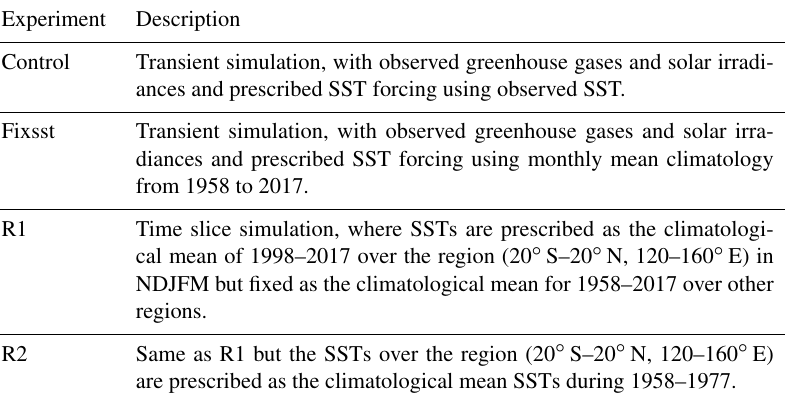
Figure 2. Trends of vertical velocity and horizontal winds at 150, 500, and 700hPa in NDJFM (November–March), as derived from JRA55, ERA5, and MERRA-2 data. The trends of horizontal winds (arrows; 10 − 1 ms − 1 a − 1 ) and vertical velocity (shading; 10 − 4 ms − 1 a − 1 ) at (a) 150hPa, (d) 500hPa, and (g) 700hPa from JRA55 in NDJFM during 1958–2017 are shown. Panels (b) , (e) , and (h) are the same as panels (a) , (d) , and (g) but for the results from ERA5. Panels (c) , (f) , and (i) are the same as panels (a) , (d) , and (g) , except that the trends are during 1980–2017 and the wind field data are from MERRA-2. The vertical velocity trends over the dotted regions are statistically significant at the 95% confidence level. The white areas denote missing values. The black rectangles denote the TWP region (20 ◦ S–10 ◦ N, 100–180 ◦ E). Table 2. Description of simulations with